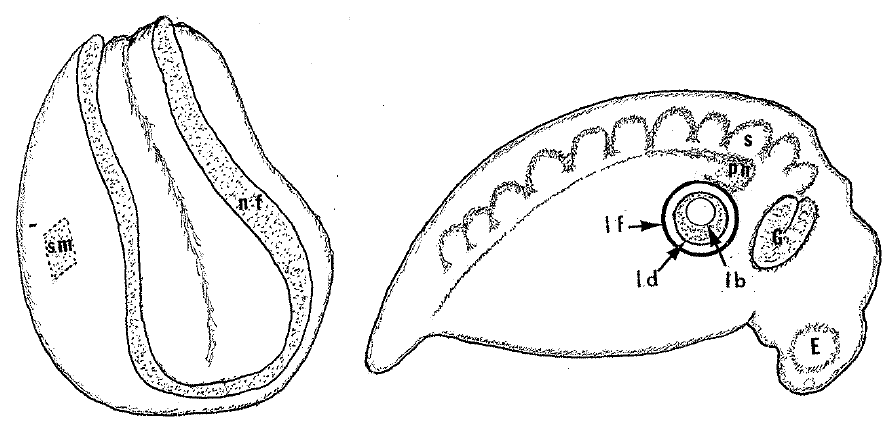
FIGURE 1. Normal embryonic salamander forelimb primordial. Left: neurula embryo (stage 15); SM: somitic mesoderm (muscle); nf: neural fold (future brain, bottom). Right: tailbud embryo: forelimb zones; lf: limb field; ld: limb disc; lb: limb bud; S: somite; G: gill; E: eye; pn: